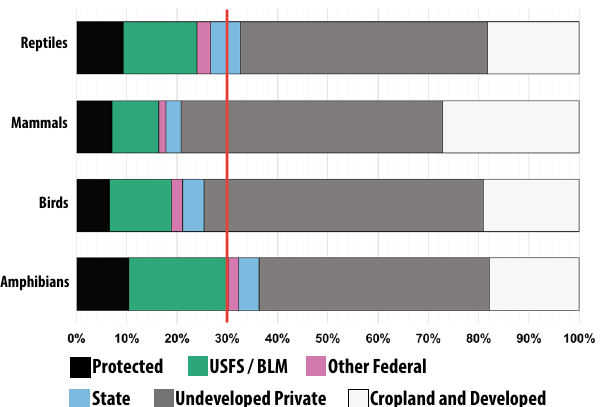
Figure 2. The average percent of endangered species ranges within each type of land designation by tetrapod class. The red line shows the 30% threshold for adequate protection of a